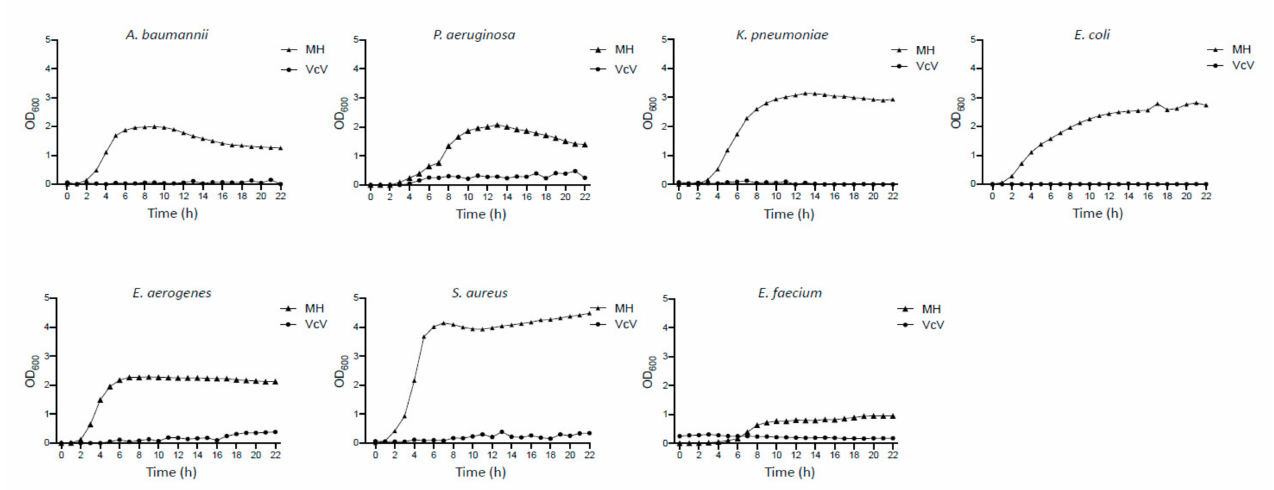
Figure 2. Growth curves of the bacterial strains indicated in the presence of the blueberry extract VcV (104.9 µ g mL − 1 ). MH: control group (absence of extract). The data corresponds to the mean of the three biological replicates.